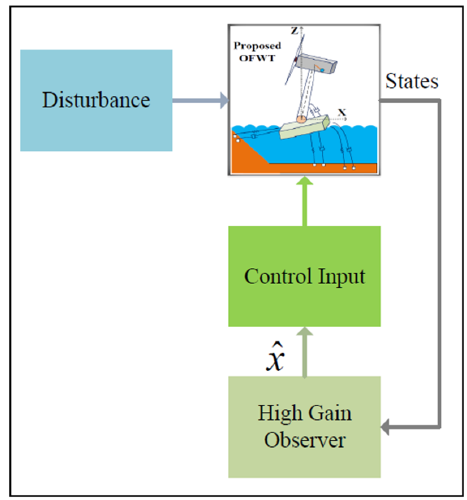
Figure 2. Schematic diagram of the adaptive robust control scheme for OFWT system.